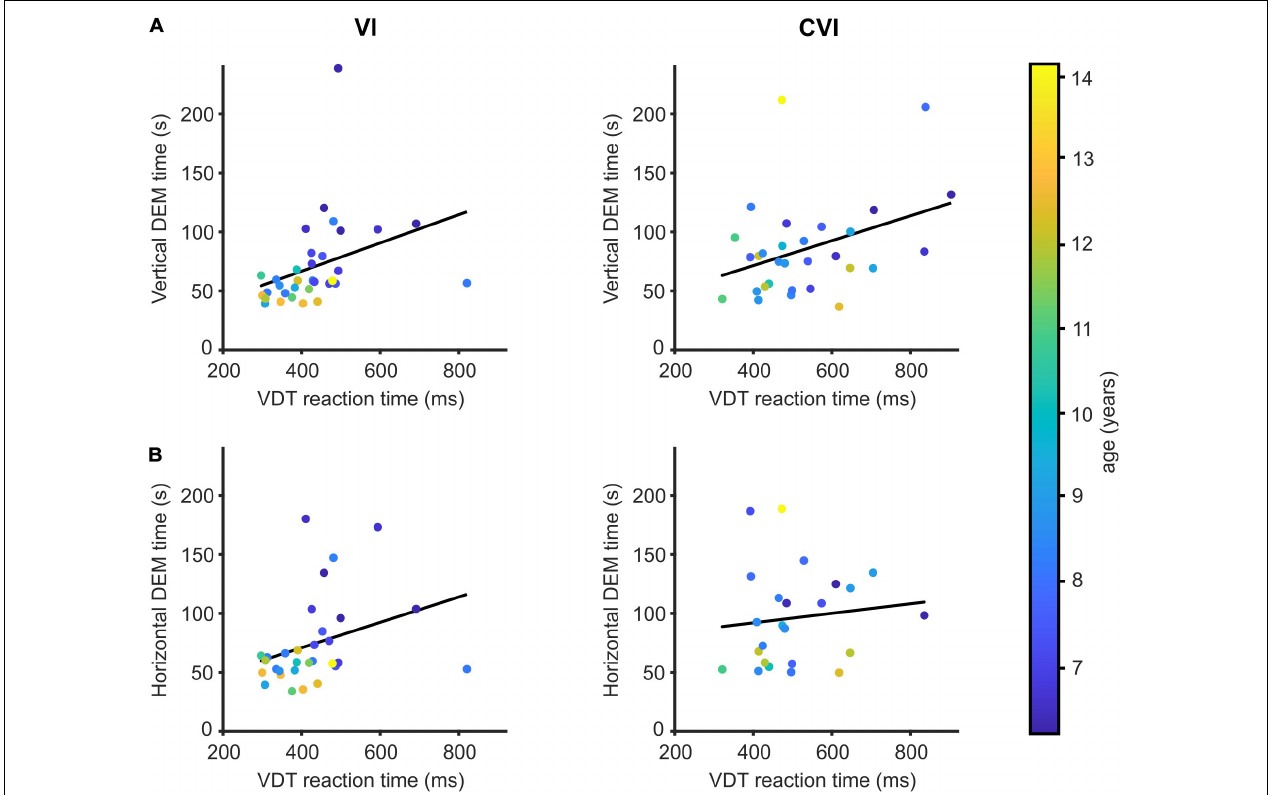
FIGURE 2 | DEM performance in relation to visual detection time. (A) Mean reaction time to detect a large visual stimulus compared to the time needed to perform the vertical DEM for children with VI (left) and children with CVI (right). Regression lines in black. Data points are color-coded by age of the child. (B) Same as (A) , but for the horizontal